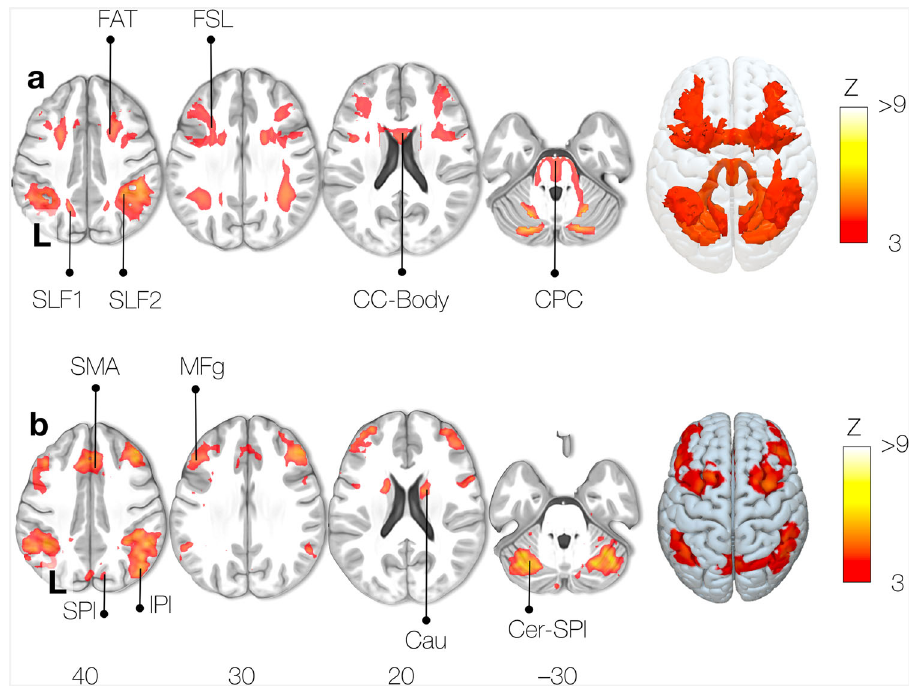
Fig. 5 Working memory task activation network. a Functionnectome-derived activation map, ( b ) Classic fMRI activation map. FAT: Frontal Aslant Tract, FSL: Frontal Superior Longitudinal tract, SLF: Superior Longitudinal Fasciculus, CC-Body: Corpus Callosum body. CPC: Cortico-Ponto-Cerebellar tract, SMA: Supplementary Motor Area, SPL: Superior Parietal lobe, IPL: Inferior Parietal lobe, MFg: Middle frontal gyrus, Cau: Caudate nucleus, Cer-SPl: Superior Posterior lobe of the Cerebellum.